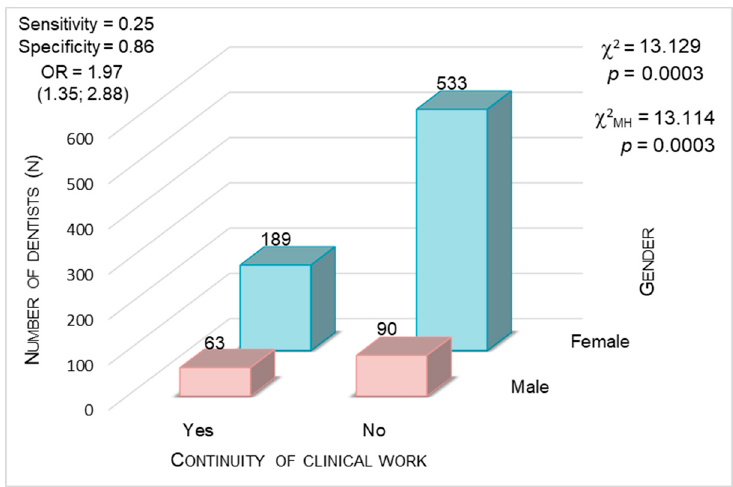
Figure 4. Continuity of clinical work during the COVID-19 outbreak in Poland vs. gender ( p < 0.0001, chi-square test).